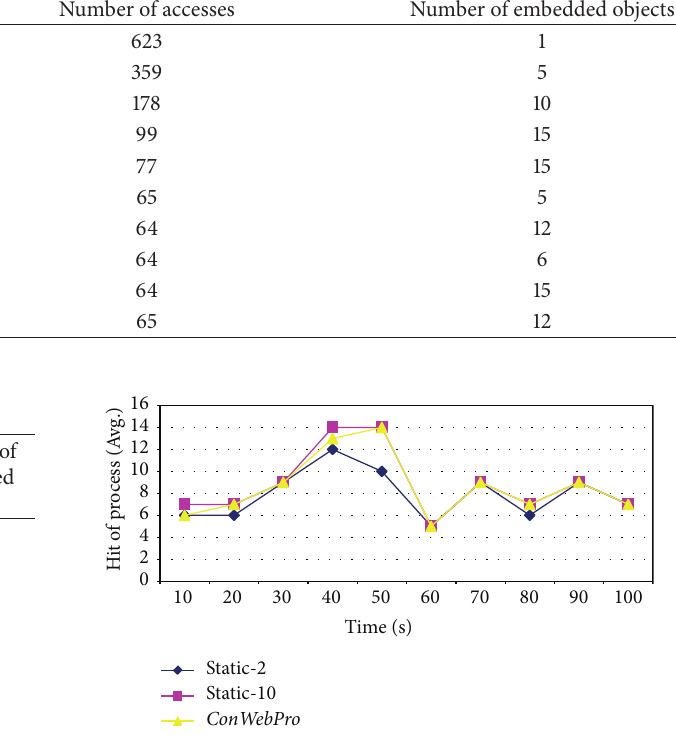
Figure 6: The average hit request at Gangneung-Wonju National University web traces.